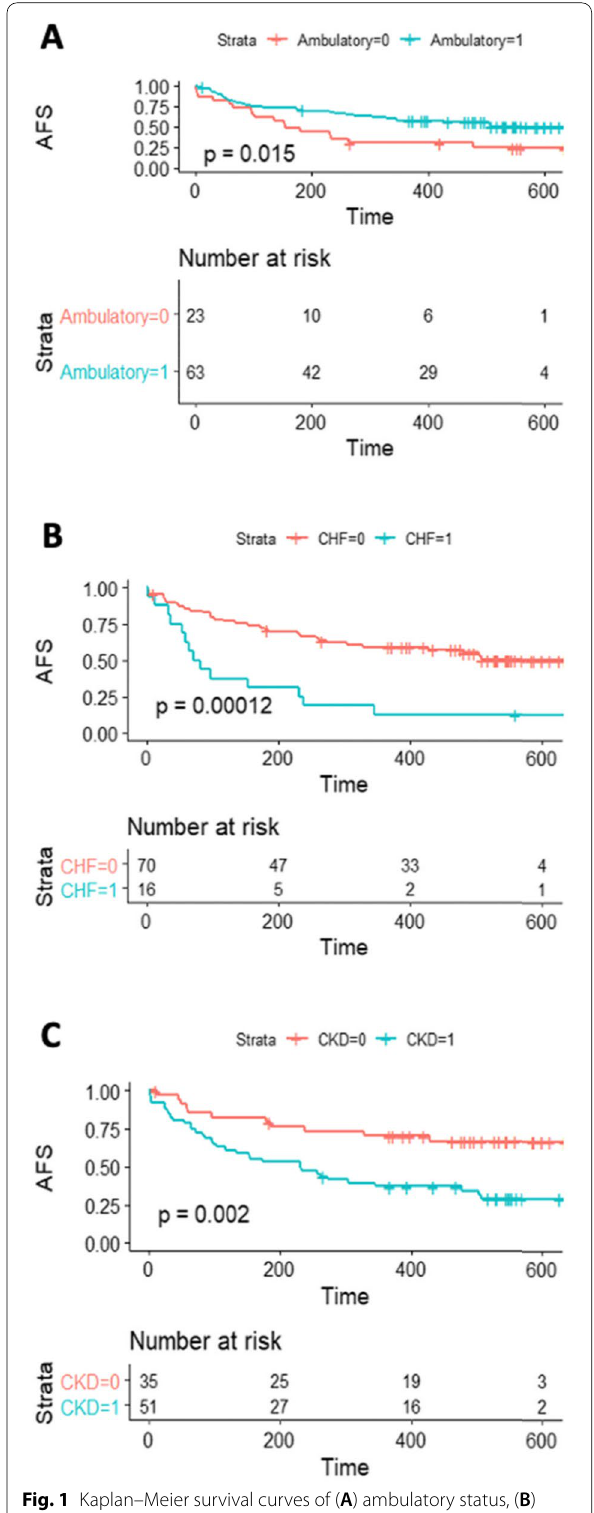
Fig. 1 Kaplan–Meier survival curves of ( A ) ambulatory status, ( B ) congestive heart failure and ( C ) chronic kidney disease, independent predictors of lower 12-month